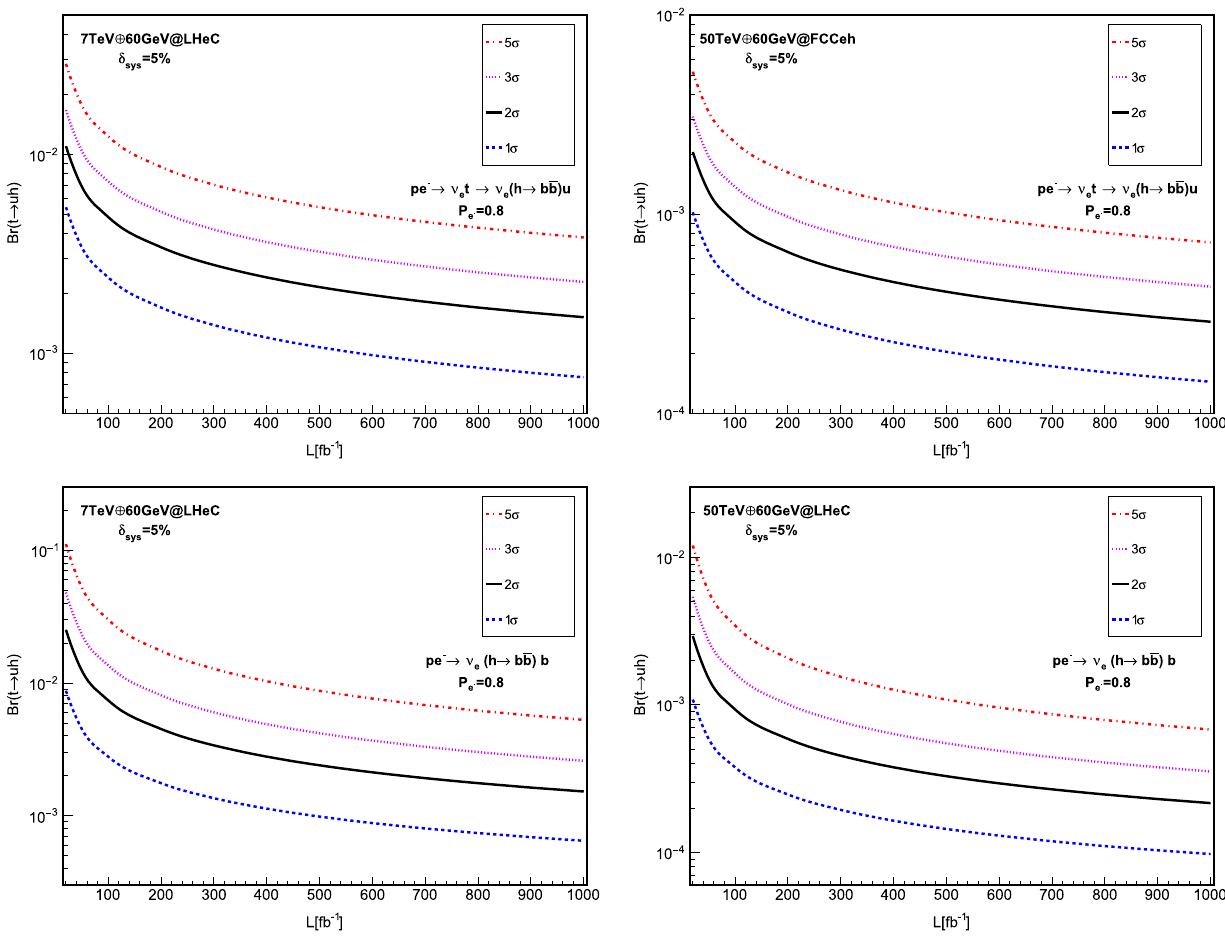
Fig. 6 The upper limit on Brt → uh ) at 99.99, 99.73, 95.40, 68.27% C.L. as a function of the integrated luminosity at the 7 (50) TeV LHeC (FCC-eh) with 60 GeV electron beam for signal I and signa.II. The dashed blue, black solid, dotted violet and dash-dotted red curves